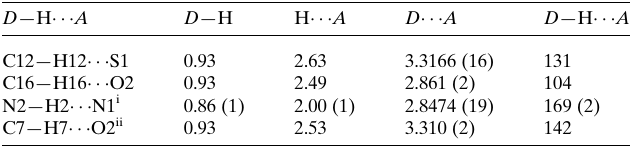
Table 1 Hydrogen-bond geometry (A˚ , (cid:2)